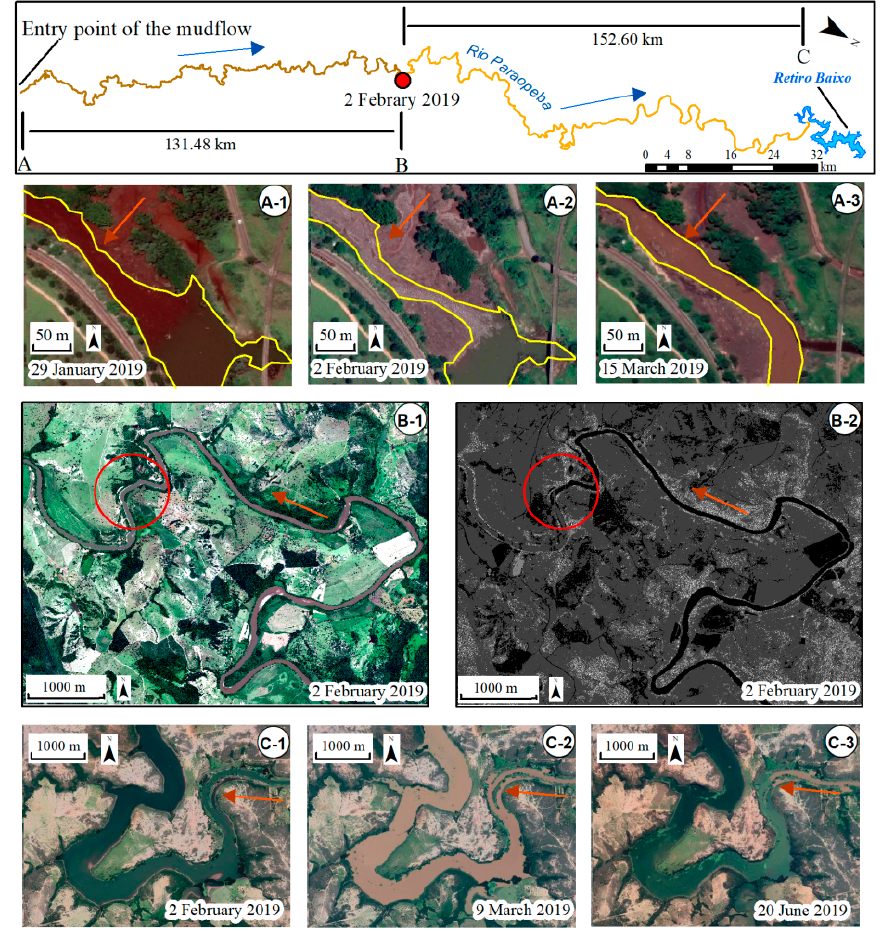
Figure 8. Transport process of waste in the Paraopeba River. A—1, 2, 3 = images of the entry point of the mudflow into the Paraopeba River, the yellow lines are used to mark the river boundary; B—1, 2 = images on 2 February 2019 around point B in the Paraopeba River, the watercolor change can be seen; C—1, 2, 3 = images of the entry point into the Retiro Baixo. Table 4. Sediment transport time nodes.